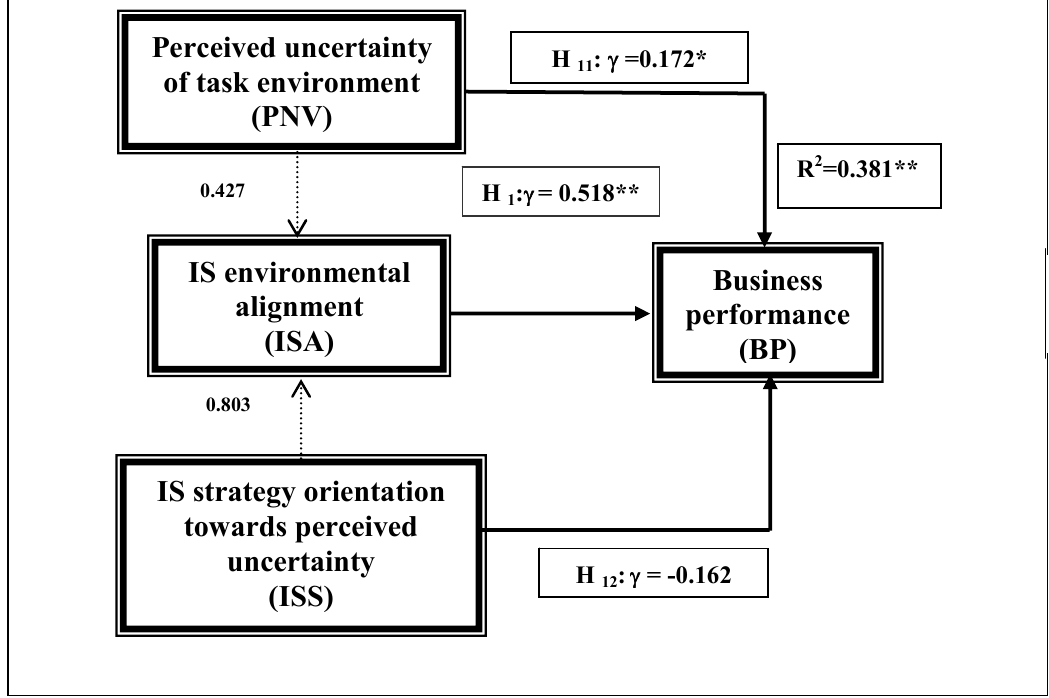
Figure 9: IS environmental alignment model showing the results Note: Alignment measurement after Chan et al., 1997 γ = Path coefficient * Path statistically significant at p = 0,025, ** statistically significant at p =